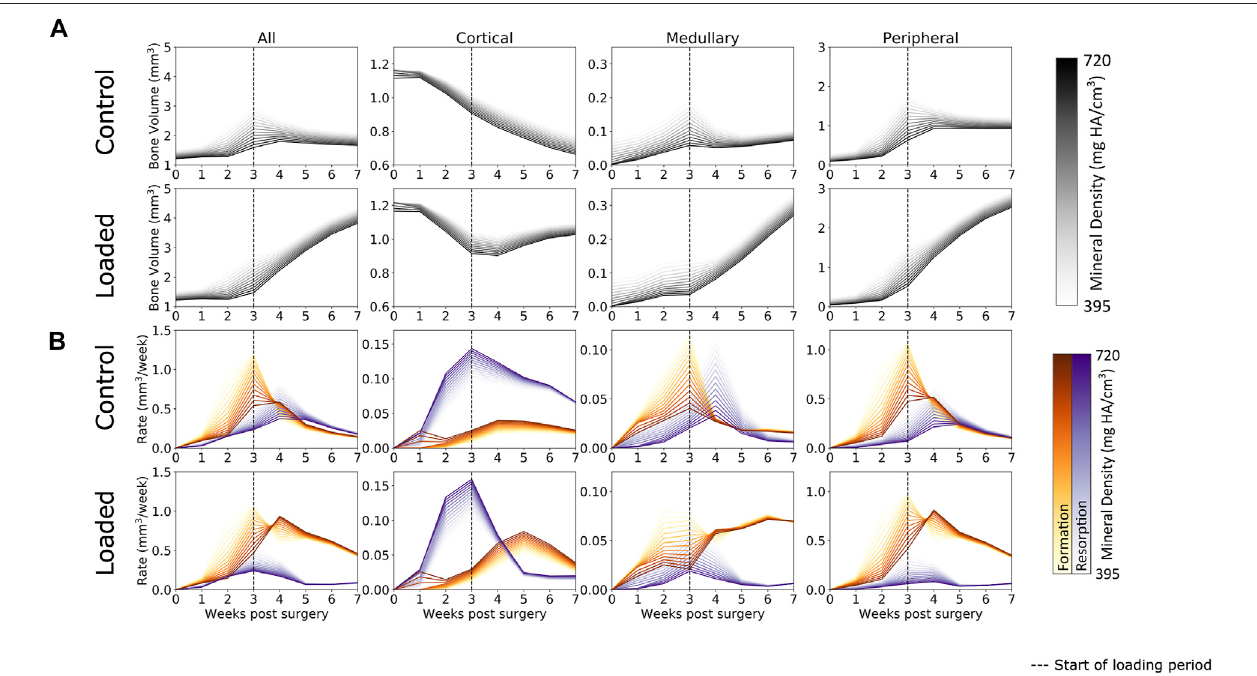
FIGURE3|(A) Bonevolumeover time infemur defect regions. In both theloaded and control groups, lowlymineralizedtissue startstoform at week 1.Afterweek 3, mineralization occurs and the control group remodels away excess tissue, while the loaded group continues to form both lowly mineralized and mineralized tissue. A similar pattern is seen in the medullary and peripheral regions, while the cortical region sees substantial bone resorption, a process which is arrested by loading. (B) Formation andresorptionratesovertime.Inallregions, peakformationoccursat week3,whileloadingincreases theamount ofmineralizedtissueforming at week 4. Similar patterns are seen in the medullary and peripheral regions, while resorption dominates the cortical region for the control group. Loading increases the rate of formation and decreases the rate of resorption in the loaded group ’ s cortical